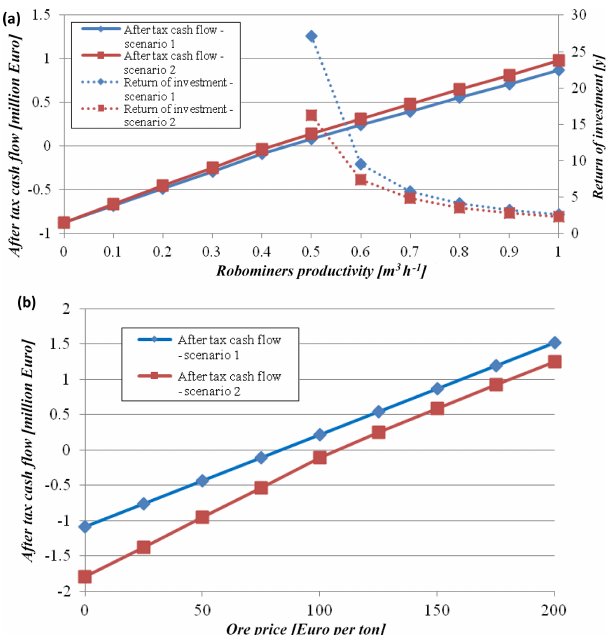
Figure 4. (a) Marginal profitability parameters for ROBOMINERS: scaling of expected productivity and after tax cash flow and return of investment. (b) Marginal profitability parameters: scaling of ex- pected ore price and after-tax cash